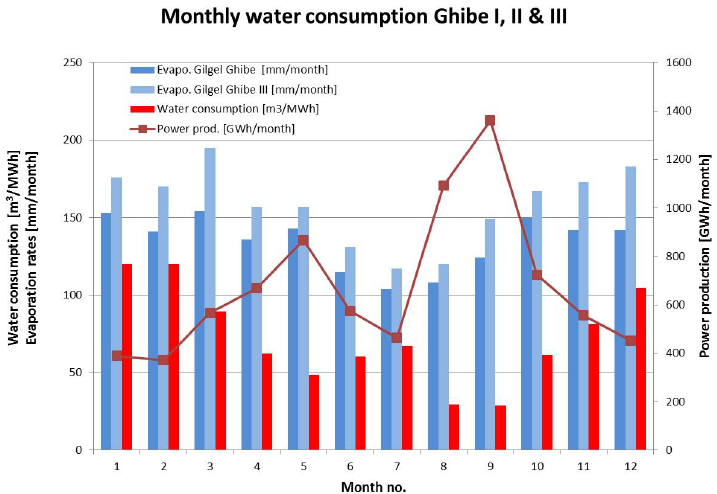
Fig. 3. The graph presents the monthly evaporation rates from the two reservoirs supplying Ghibe I, II and III power plants with water, monthly power production from the year 2005 and correspondingly monthly (gross) water consumption estimates (based on Yesuf,